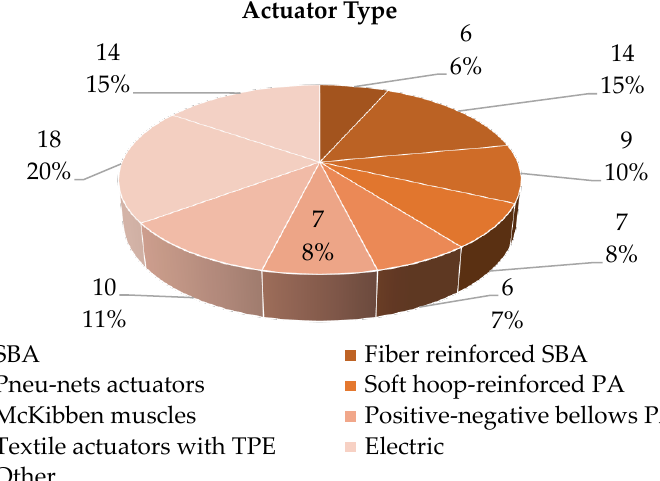
Figure 28. Distribution of actuators used in the soft gloves of the revised articles, divided into the following classes: soft bending actuators (SBAs), fiber reinforced SBAs, pneu-nets actuators, soft hoop-reinforced pneumatic actuators, McKibben muscles, positive–negative bellows pneumatic actuators, textile actuators with thermoplastic elastomers (TPE), electric actuators, and Others.